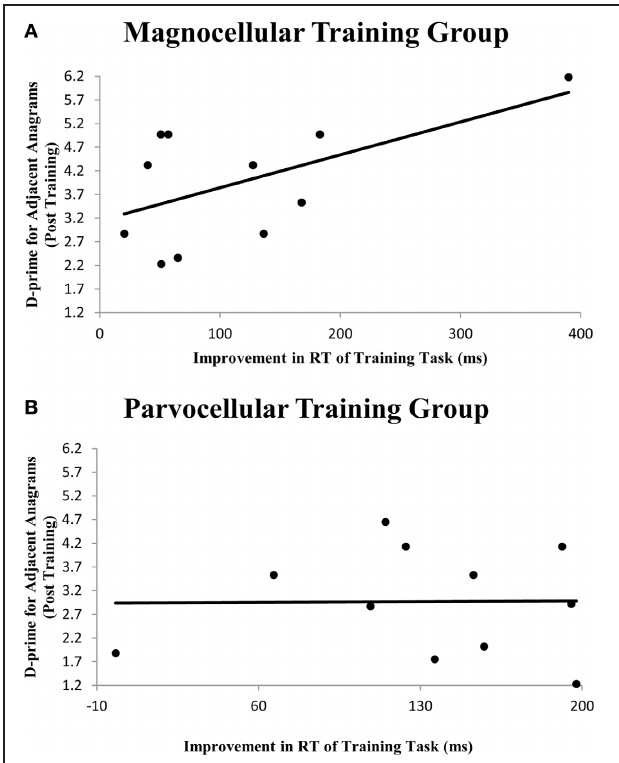
FIGURE 1 | Scatterplot between an improvement variable for performance on visual training and a d -prime variable for performance on a lexical decision task post-training. While RT improvement in magnocellular training (A) correlated with the d -prime for adjacent anagrams ( r = 0 . 576, p = 0 . 032), improvement in parvocellular training (B) did not ( r = 0 . 010, p = 0 . 488). A similar pattern was found for words (see Table 3 ; graph not shown).